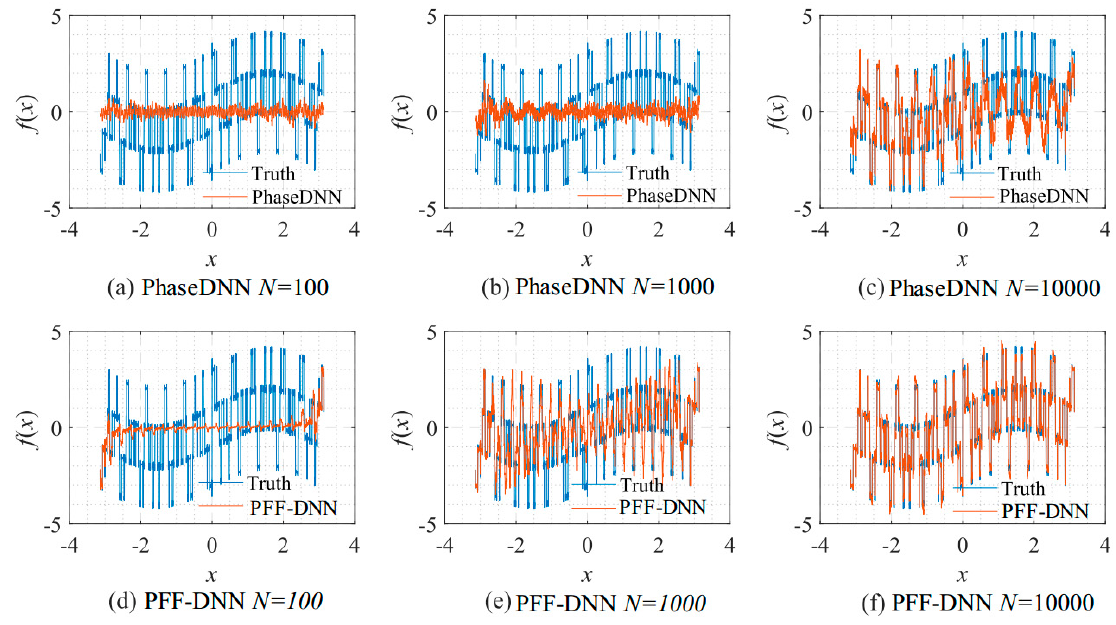
Figure 25. The influence of N on the algorithm performance. Fitting results of the PhaseDNN method when Δ ω = 11: ( a ) N = 100; ( b ) N = 1000; and ( c ) N = 10,000. Fitting results of the PFF-DNN method when Δ ω = 11: ( d ) N = 100; ( e ) N = 1000; and ( f ) N = 10,000.